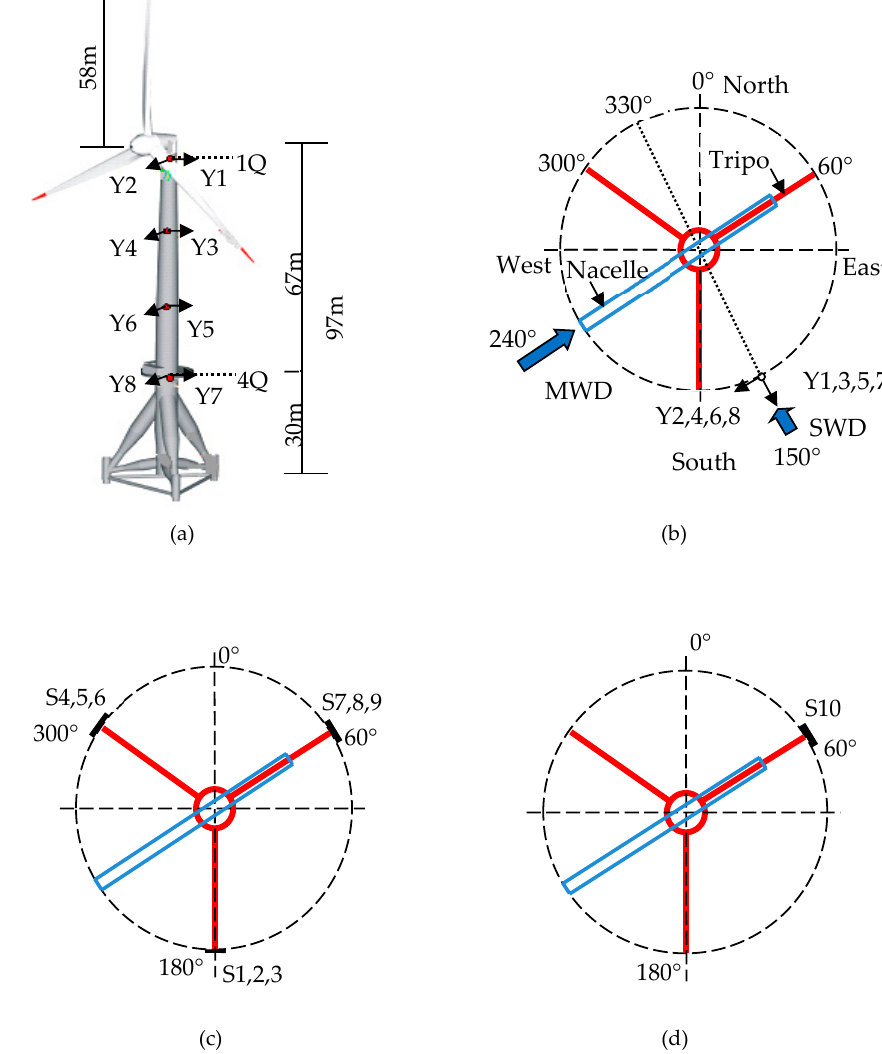
Figure 8. Arrangement of sensors on the wind turbine: ( a ) Positions of the eight accelerometers and section 1Q and 4Q; ( b ) plane view of the wind turbine and wind direction; ( c ) positions of the strain gauges in section 1Q; ( d ) positions of the strain gauges in section 4Q.